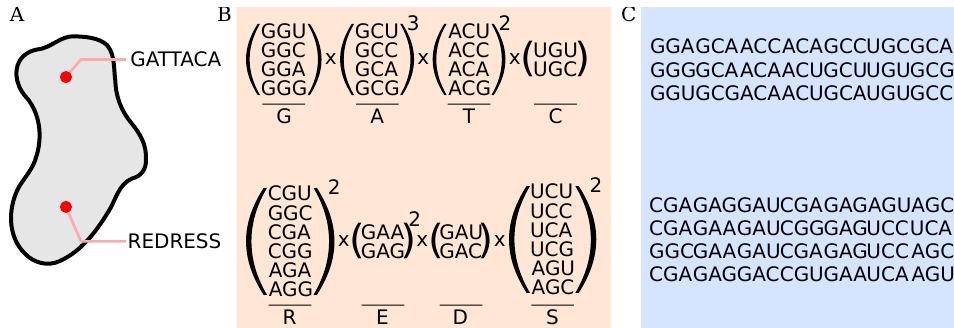
Figure 5. Illustration of phenotypic redundancy in a neutral nucleotide-to-amino-acid-sequence model. ( A ) The space of protein sequences of the same length is vast and contains a variety of functional sequences. ( B ) The number of codons representing amino acid i varies; here, it corresponds to its versatility v i . Codons coding for glycine (G), alanine (A), threonine (T), cysteine (C), arginine (R), glutamic acid (E), aspartic acid (D), and serine (S) are shown here explicitly as examples. ( C ) Possible nucleotide sequences coding for GATTACA (above) and REDRESS